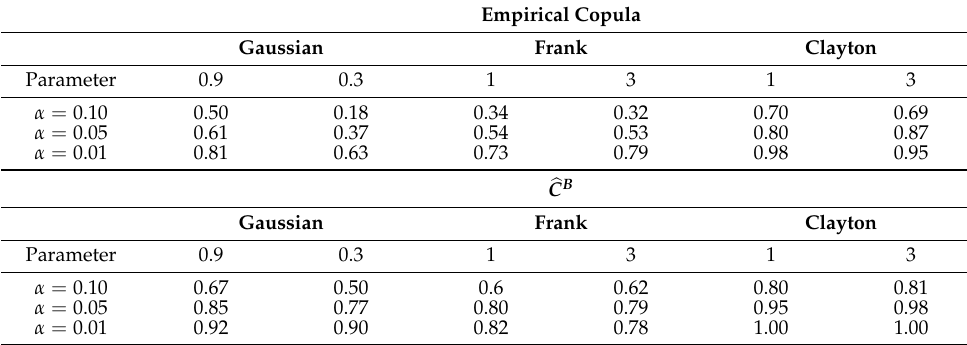
Table 4. Error type 2 calculated with different significant levels α